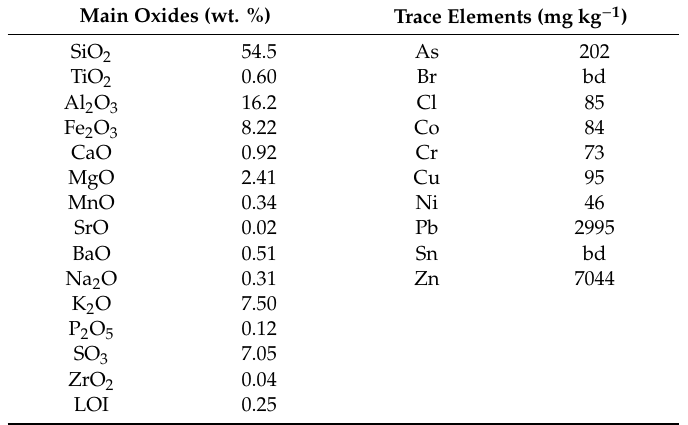
Table 3. Chemical composition of the long-term stored waste rock used in the experiments. Main Oxides (wt. %)